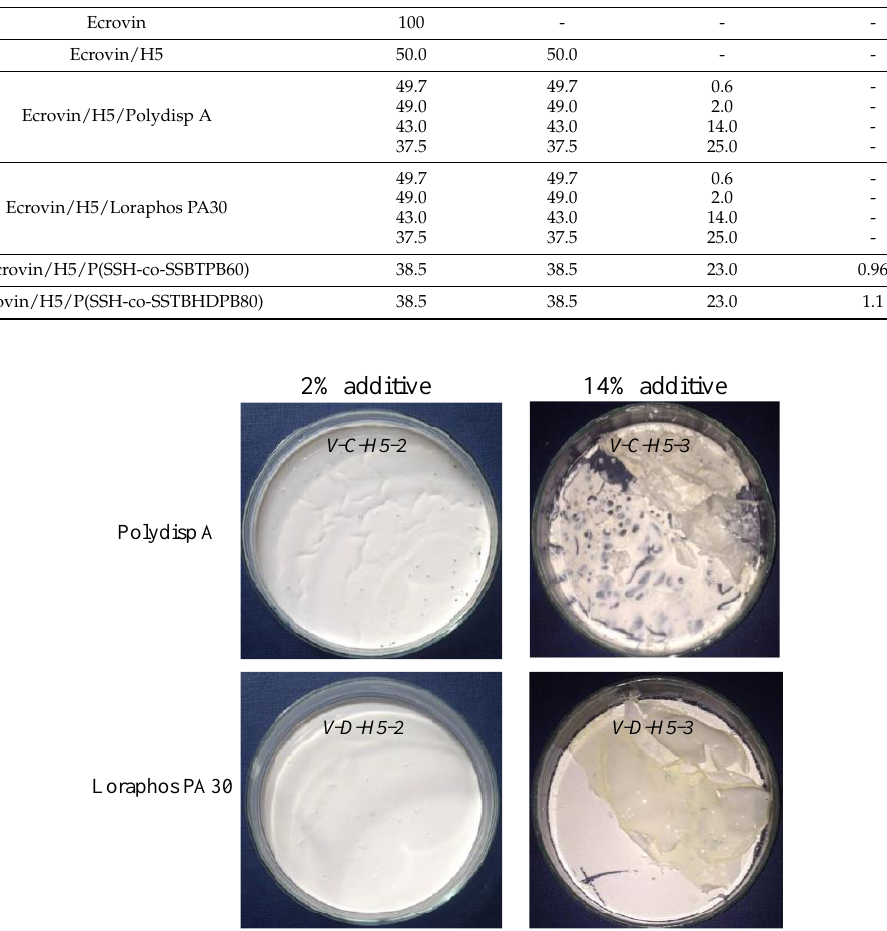
Figure 9. Photographs of the films Ecrovin/H5 with Polydisp A and Loraphos PA30 at 2 and 14% content.